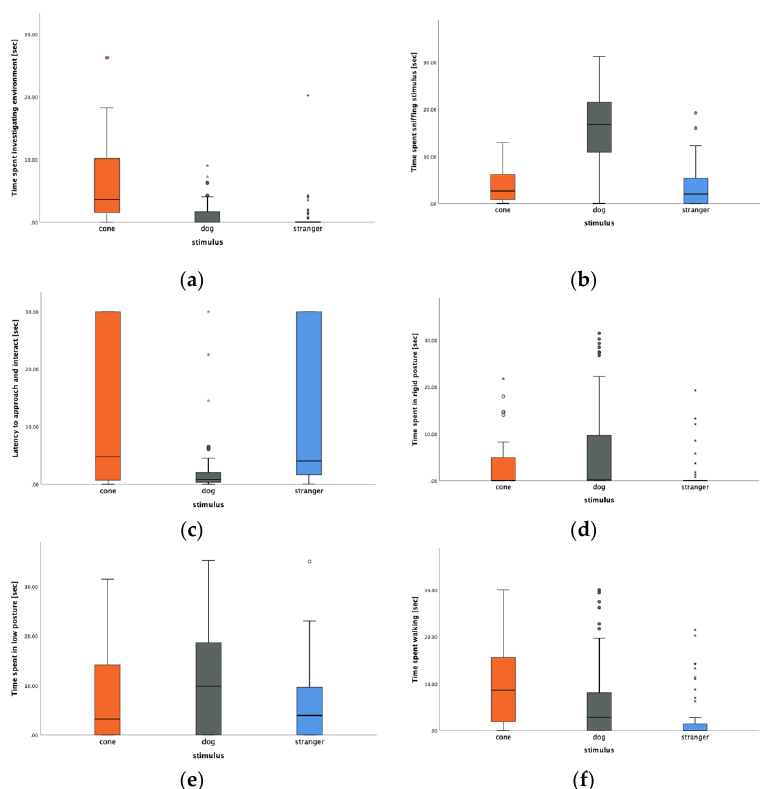
more time displaying rigid postures when presented with the dog statue than when pre- sented with the cone and the stranger ( p = 0.010 and p = 0.016, respectively, Figure 1d). They also spent more time in lowered postures when presented with the dog statue com- pared to the stranger ( p = 0.001, Figure 1e) but not with the cone. Finally, dogs spent less time performing “walking” behavior during the stranger approach test than they did when presented with either the cone or dog statue ( p = 0.0001, Figure 1f).